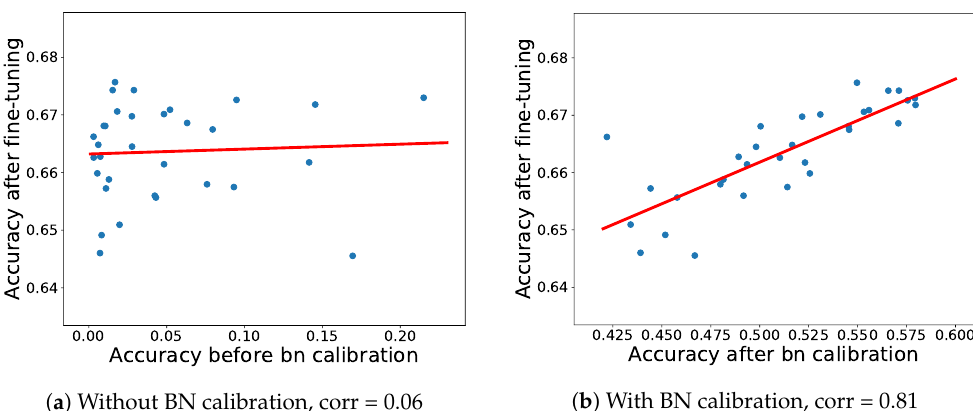
Figure 3. Accuracy after vs. before fine-tuning without ( a ) and with BN calibration ( b ). The plot is based on 38 different networks compressed using CPD-EPC (with different rank sets and a fixed 3 FLOP compression ratio) and fine-tuned Resnet-18 with the ILSVRC-2012 dataset. The accuracy × of the compressed model after the calibration of the BN statistics was strongly correlated with the post-fine-tuning model